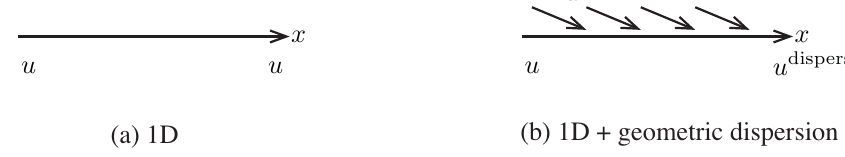
Figure 3. Scheme of inclusion of out of beam components as geometrical